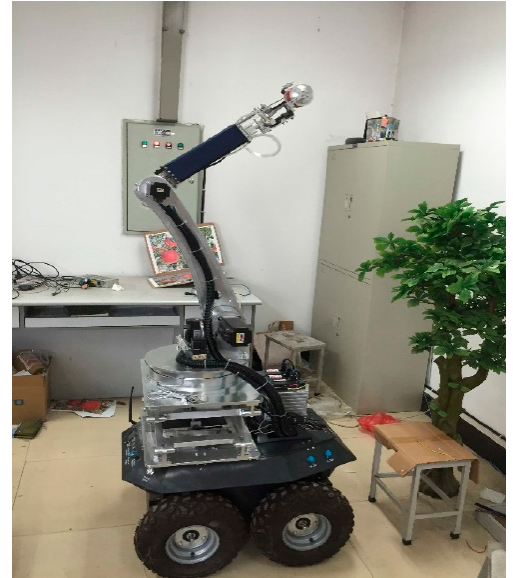
Figure 3. Picking robot physical map.